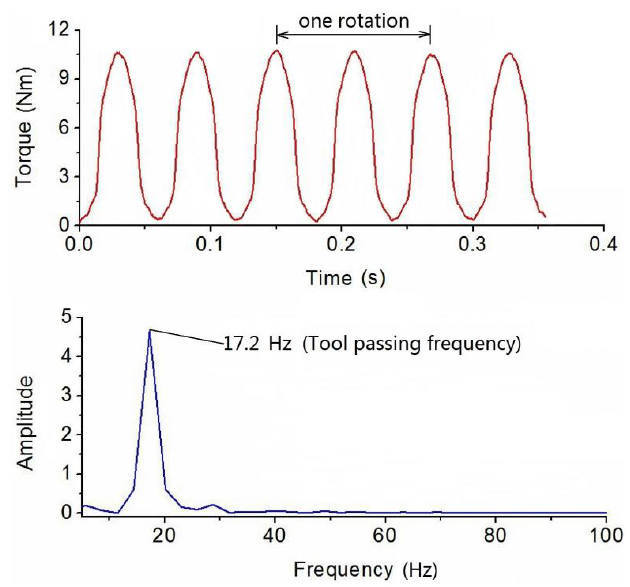
Figure 12. Plots of torque force signals in time and frequency domain at a spindle speed of 500 rpm.